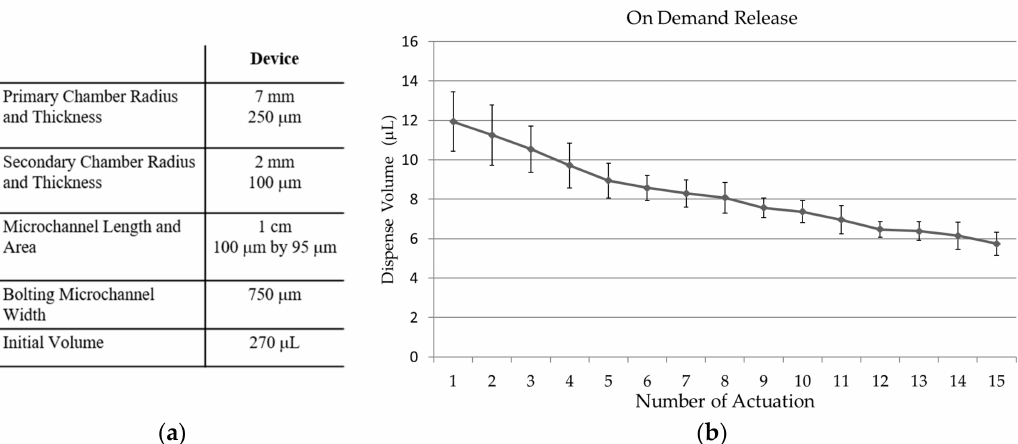
Figure 9. ( a ) Dimensions and initial conditions of the tested drug delivery device. ( b ) shows a chart of on demand release of the device described in ( a ). The device was actuated 15 times using a strong neodymium magnet.